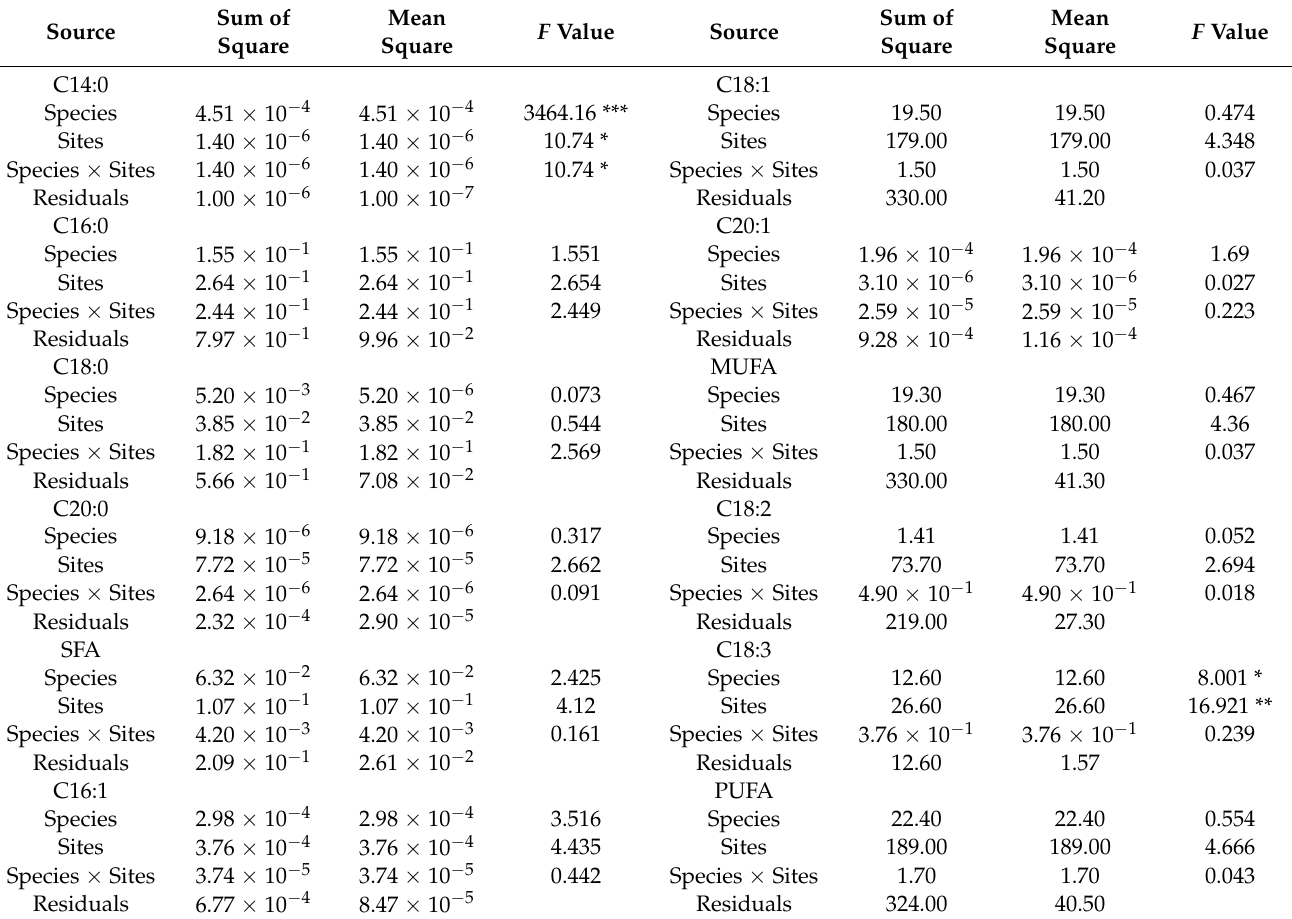
Figure 2. The correlation between the chemical characteristics of walnut oil. Note: *, **, and *** indicate significant correlations ( p ˂ 0.05, 0.01, and 0.001) between the 19 chemical characteristics of walnut oil, respectively. Table 2. Two-way analysis of variance (two-way ANOVA) of fatty acid.